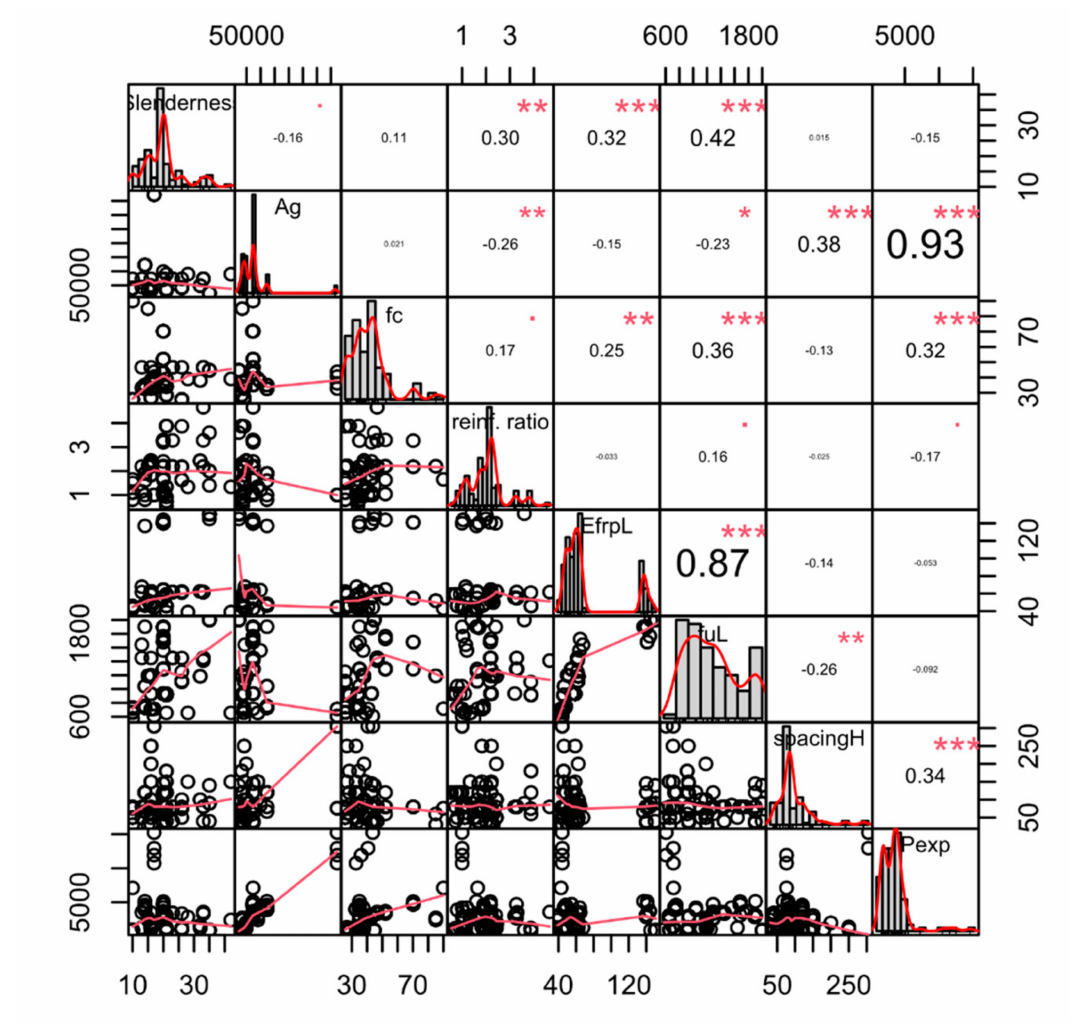
Figure 1. Correlation matrix of the